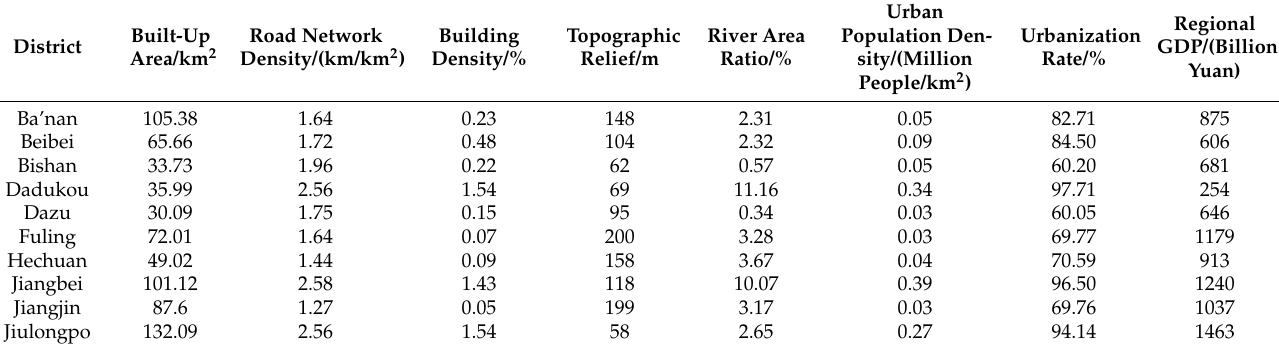
Figure 2. Partial vector building data ( a ) and partial road intersection data extracted from road network ( b ). Table 1. Driving factors in 22 administrative